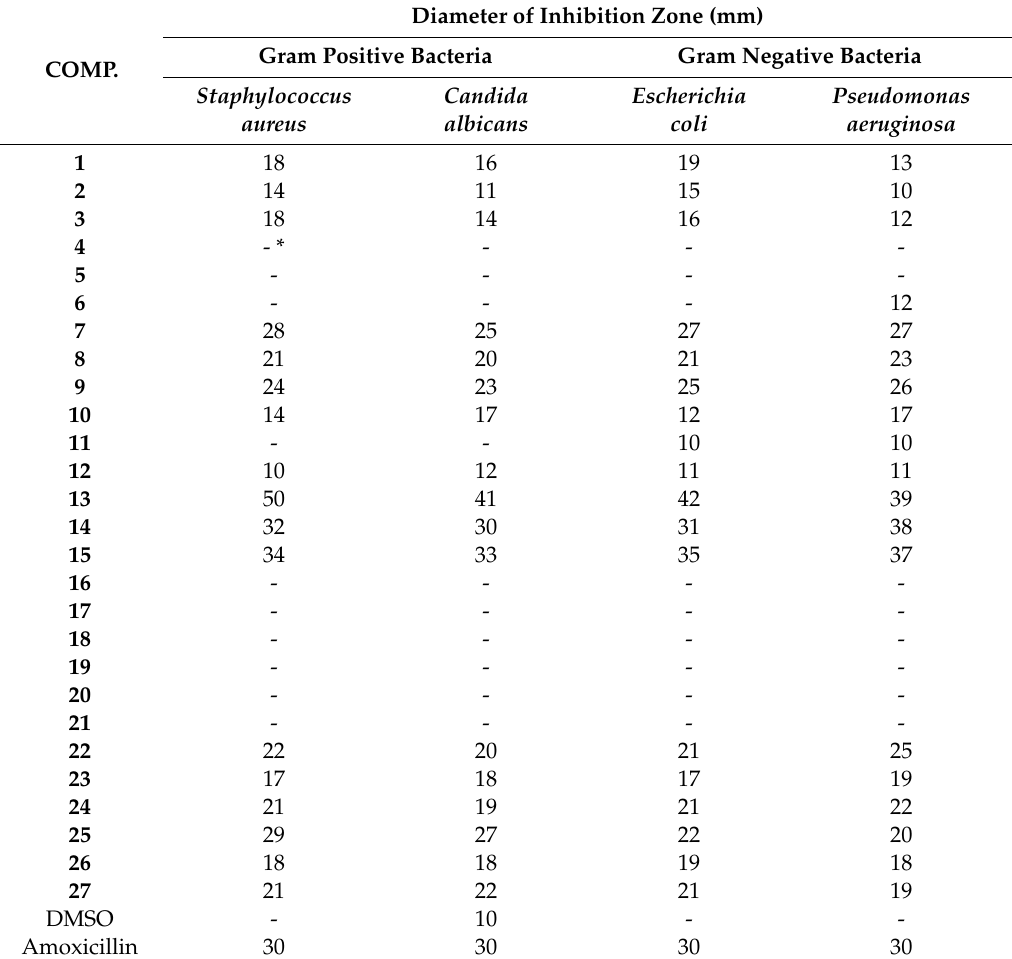
Table 2. Inhibition zones (mm) of synthetic compounds 1 – 27.